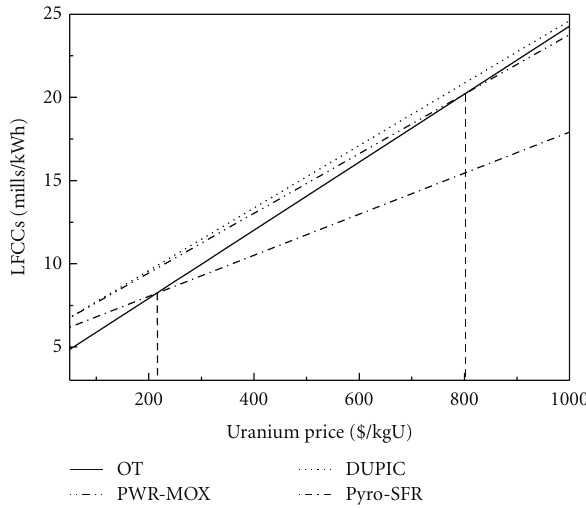
Figure 7: LFCCs dependent on the uranium price.